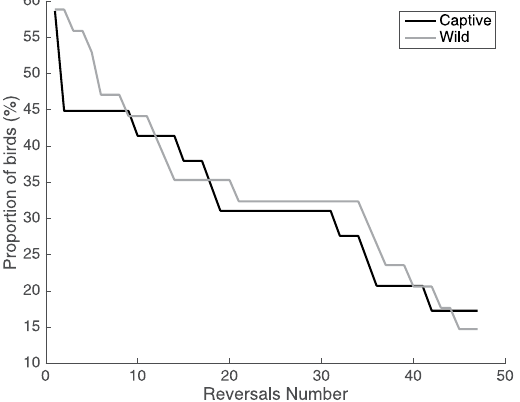
Figure 2. Proportion of individuals successful in each reversal computed over the total number of birds who were logged on a device at least once. Captive birds are in black and wild birds are in grey.